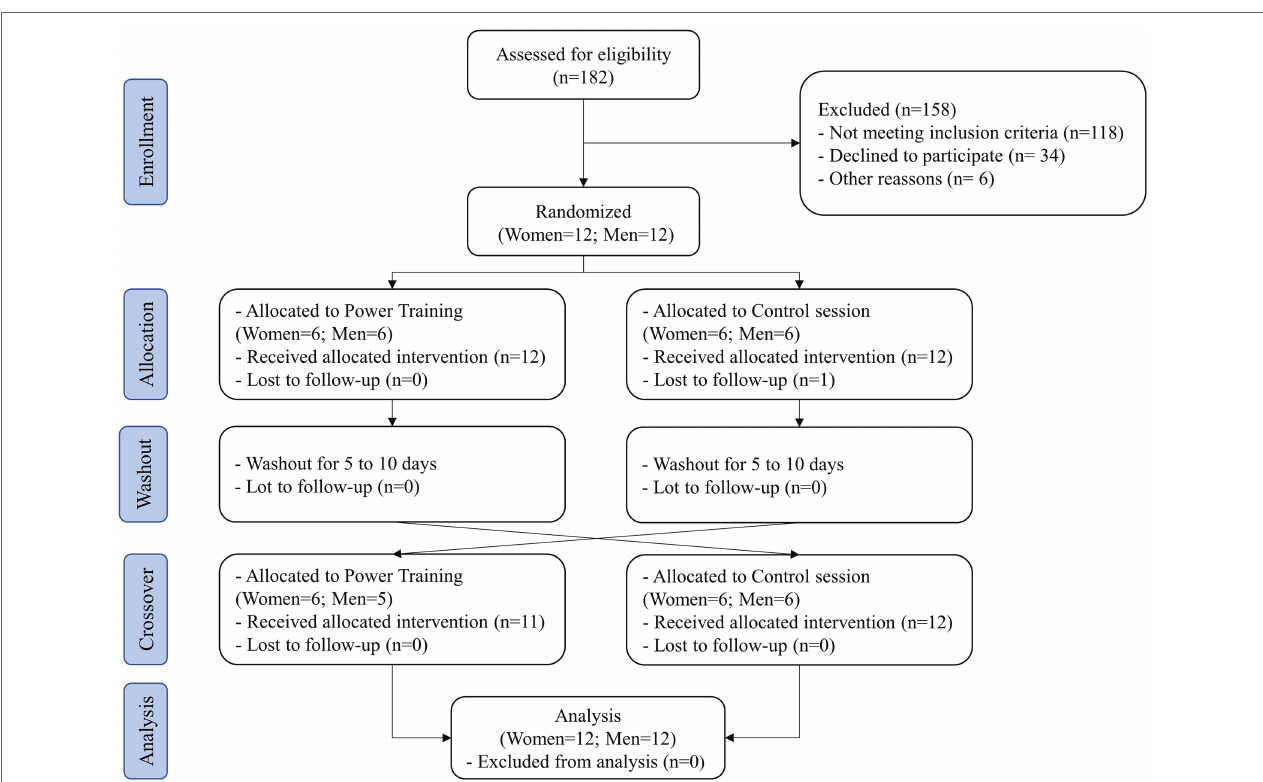
FIGURE 1 | Flow diagram of